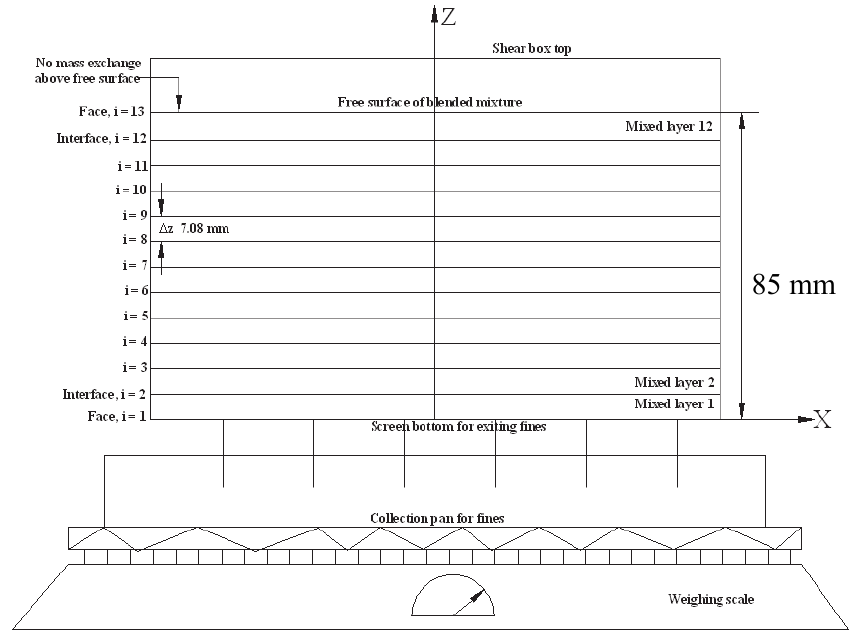
Fig. 1 Binary mixtures in shear box showing 12 equal size layers for model development.